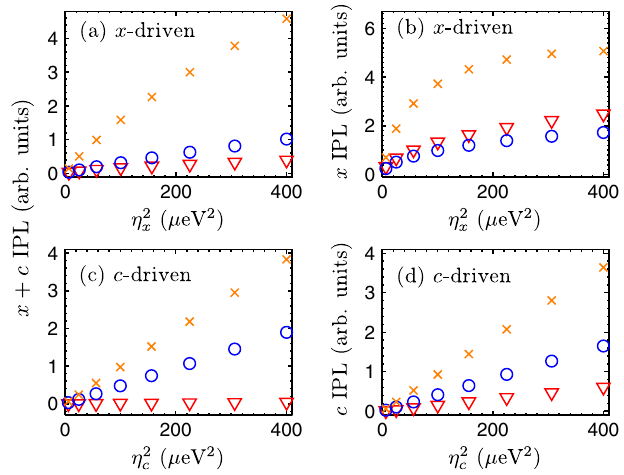
FIG. 14. Integrated PL for a dot-driven system, (a) and (b), as measured through cavity emission, and the IPL of a cavity- driven system, (c) and (d), as measured via QD emission; both as a function of the square of the cw drive for two different temperatures of the phonon reservoir ( T ¼ 4 K : blue circles, T ¼ 20 K : orange crosses); also plotted are the IPL line shape in the presence of only ZPL broadening and h B i ¼ 1 (inverted red triangles)—the corresponding (cid:7) 0 ¼ 2 (cid:8) eV (at 4 K). (a) The IPL of the total cavity and QD intensity of a dot-driven system as ¼ 3 meV and the PL measured through cavity emission; (cid:1) cx intensity are shown in Fig. 11. (b) IPL of the cavity-mode intensity over the Lorentzian centered at the QD resonance frequency. (c) IPL of the QD exciton and cavity intensity of a ¼ cavity-driven system as measured through the QD; here (cid:1) cx 0 : 5 meV and the intensity line shapes are shown in Fig. 13. (d) The IPL of the QD mode intensity over the Lorentzian centered at the cavity resonance